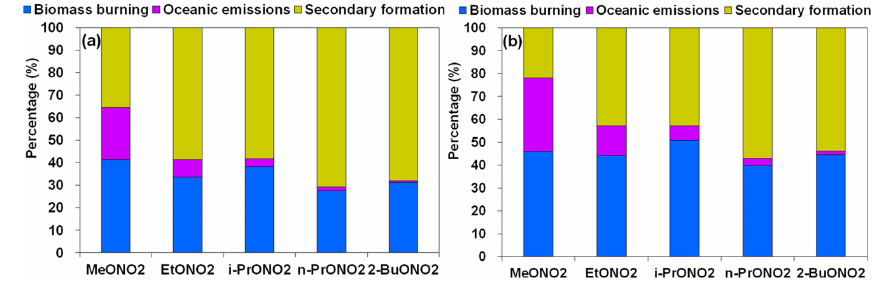
Figure 8. Source contributions to individual alkyl nitrates in (a) meso and (b) non-meso scenarios at TW (in percentage).